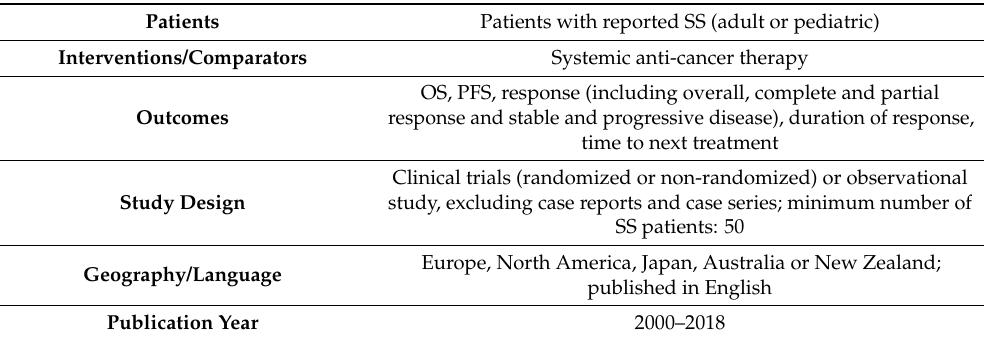
Table 1. Eligibility criteria.